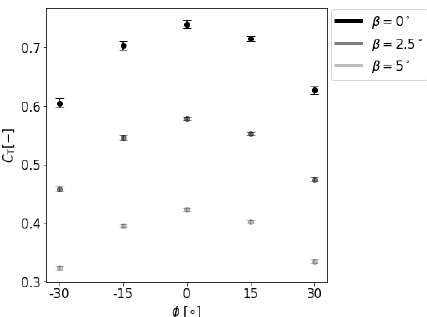
Figure 2. Overview of the effect of yaw angle φ and pitch angle β on thrust coefficient C T . Whiskers indicate the standard deviation between all eight